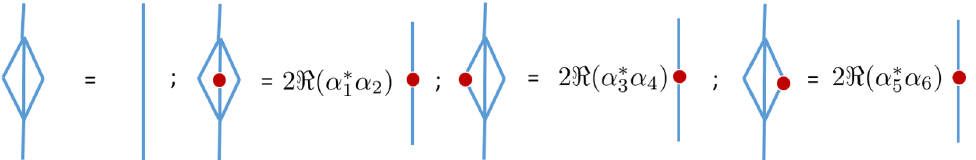
Figure 43. The tensor contracts as an isometry in the 1-3 split. Each red marker indicates an X ⊗ X operator insertion. We drop the bulk leg as we have fixed it to a specific